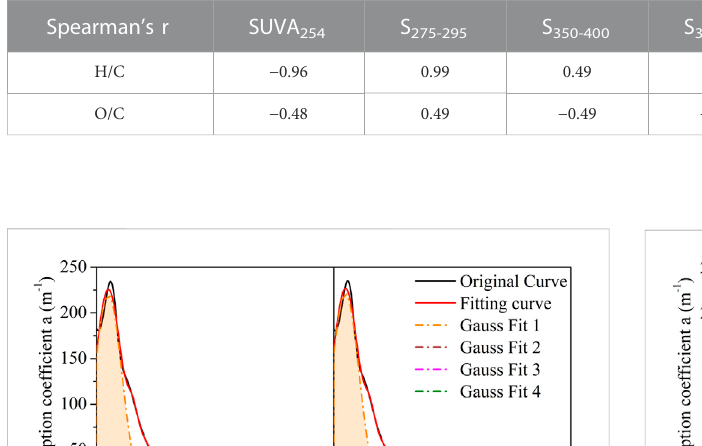
TABLE 6 Correlation coef fi cients for the elementary ratios (H/C and O/C ratios) and spectroscopic parameters derived from the aforementioned methods.